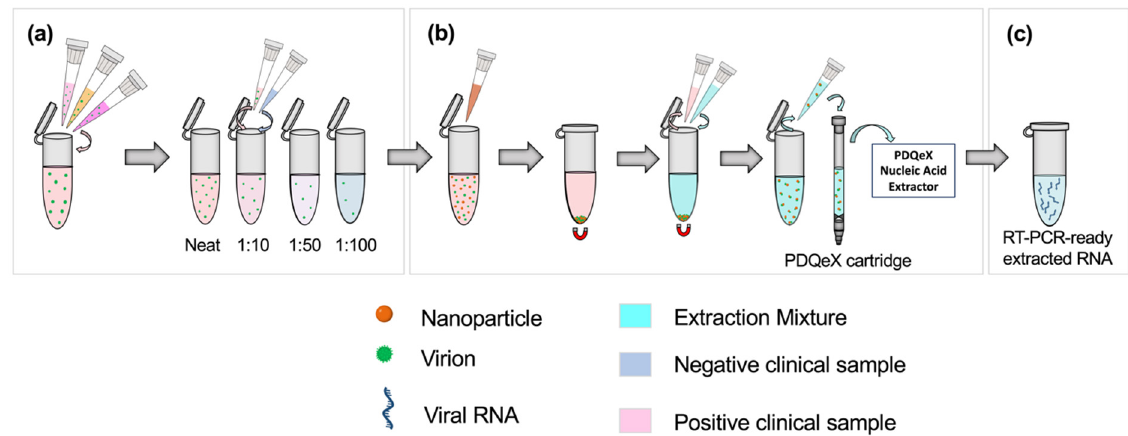
Figure 1. Schematic illustrating the workflow for sample preparation and RNA extraction. Based on the clinically assigned C T value, samples (nasopharyngeal swabs in VTM, or saliva, as appropriate) were classified as having a high, moderate, or low viral titer (C T value < 20, 20–30, or >30, respectively). ( a ) Equal volumes of three positive samples with similar clinically assigned C T values were combined to represent a pooled positive sample. The appropriate ratios were achieved by diluting this pooled positive sample in clinically negative samples. ( b ) SARS-CoV-2 virions were pre-concentrated using paramagnetic nanoparticles. This step facilitated the adsorption of virions to the nanoparticles, which were then magnetically separated from the sample. The supernatant was removed, and the extraction cocktail was added for the resuspension of nanoparticles. The desorption and extraction of RNA were then facilitated via thermocycling. This process was repeated for each dilution pool. ( c ) RT-PCR-ready extracted viral RNA.